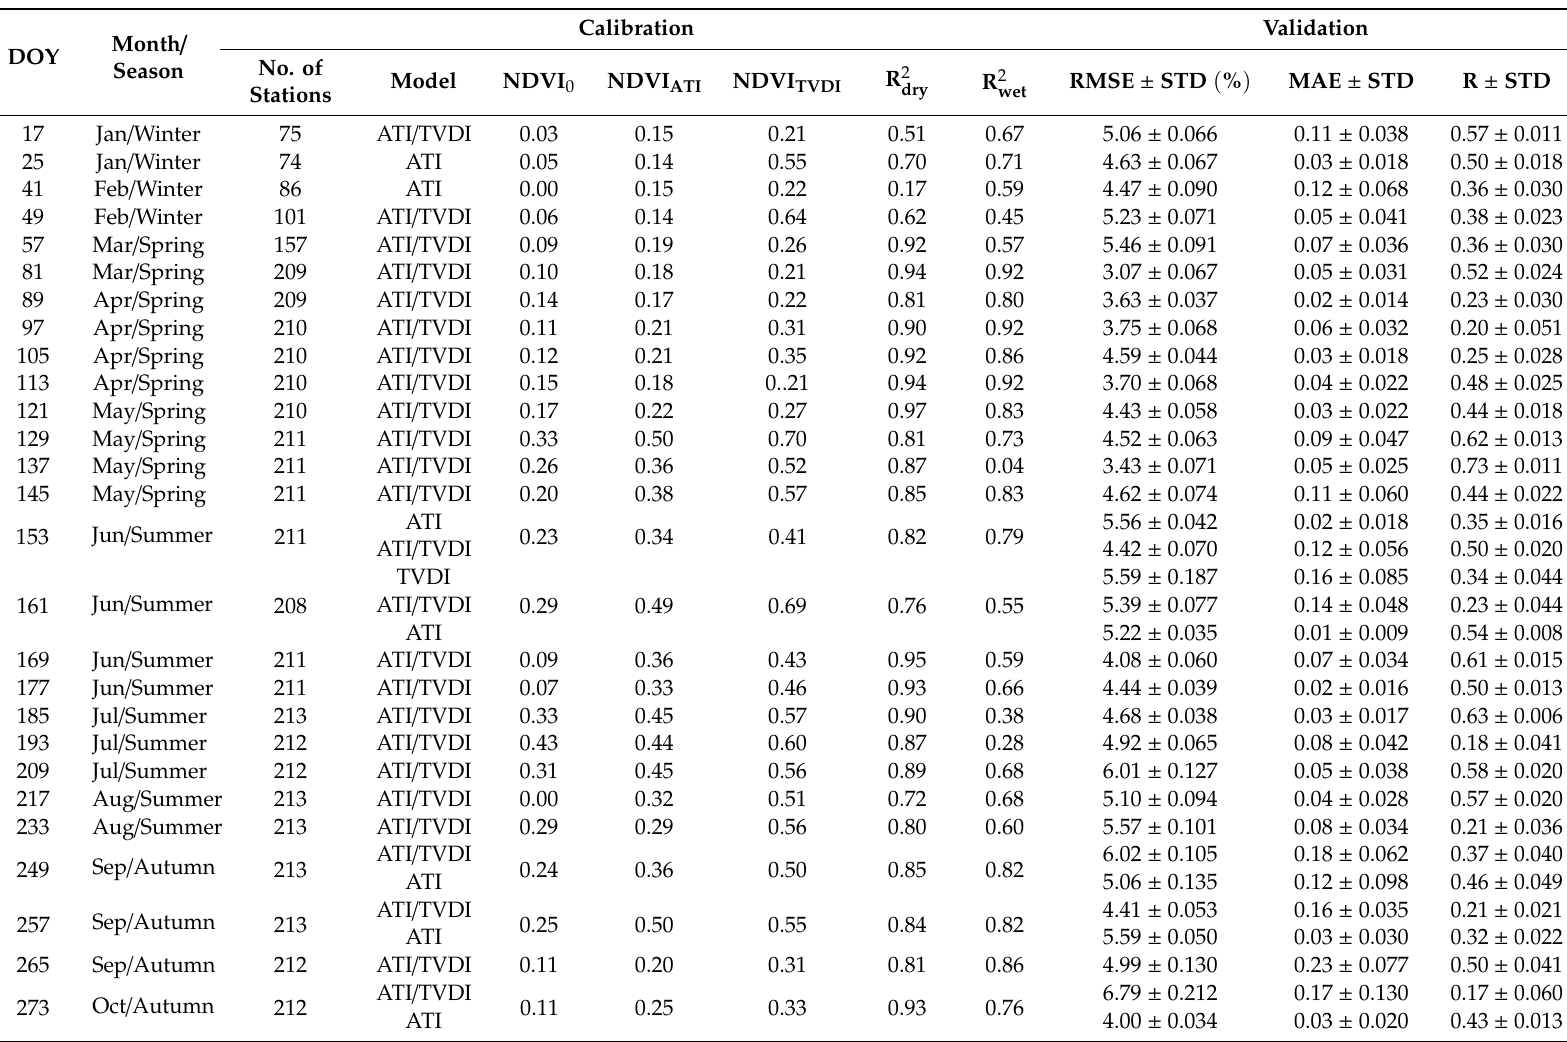
Table 3. Calibration and validation results including selected optimal NDVI thresholds and wet / dry edge fitting R 2